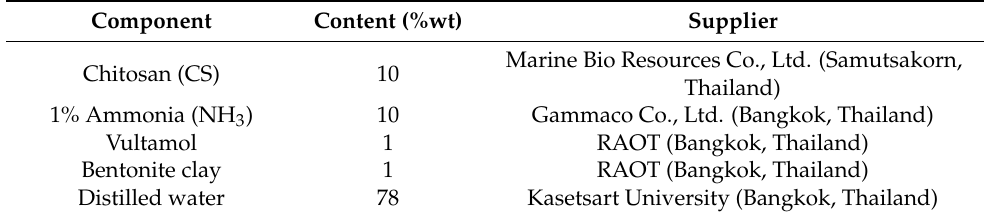
Table 3. Components for preparation of chitosan (CS) mixture and their suppliers. Component Content (%wt) Supplier Chitosan